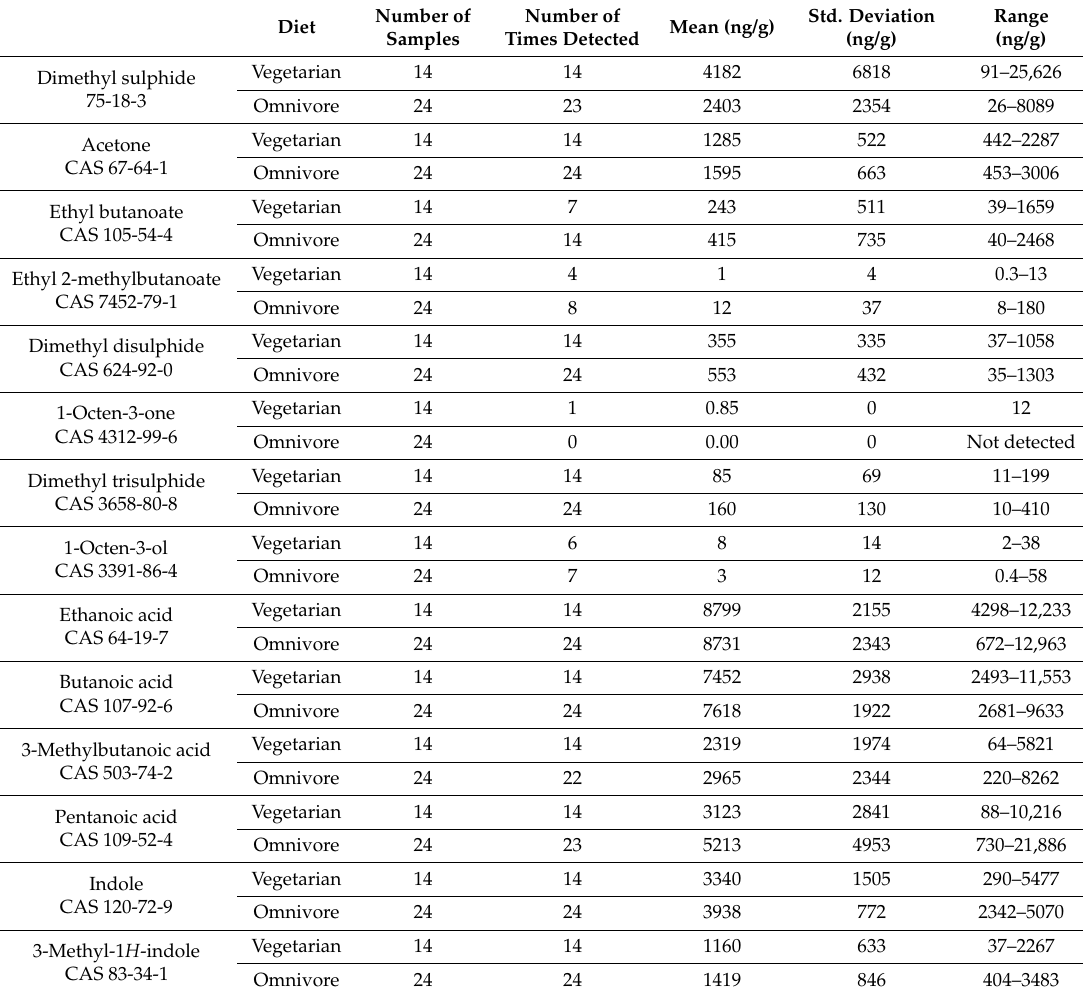
Table 3. The mean concentration (ng/g) and measured concentration range (ng/g) for each compound in the omnivore and vegetarian diet